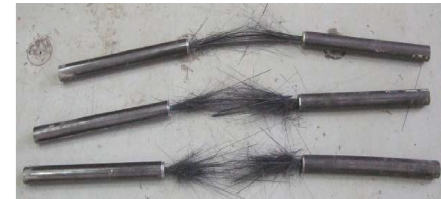
Figure 2: Results of tensile test.